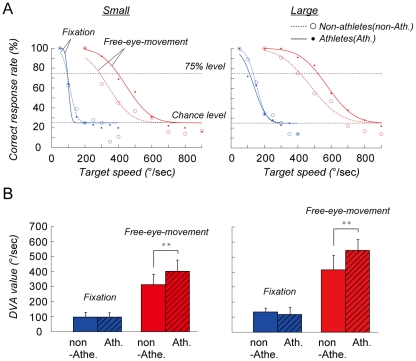
Group comparisons.(A) The mean correct response rate plotted against the target speed. The colors represent the fixation (blue) and free-eye-movement (red) conditions. The symbols the represent the non-athletes (open circles) and athletes (dots). Note the better performance of the athletes in the free-eye-movement conditions with both small (left) and large targets (right). (B) The mean target velocity that yielded a correct response rate of 75%. The threshold target velocity was used as a measure of DVA. Error bars show the standard deviation. **: p<0.01 (post hoc tests performed with the Ryan method).